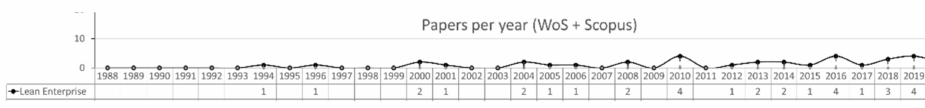
Figure 9. Lean enterprise evolution.